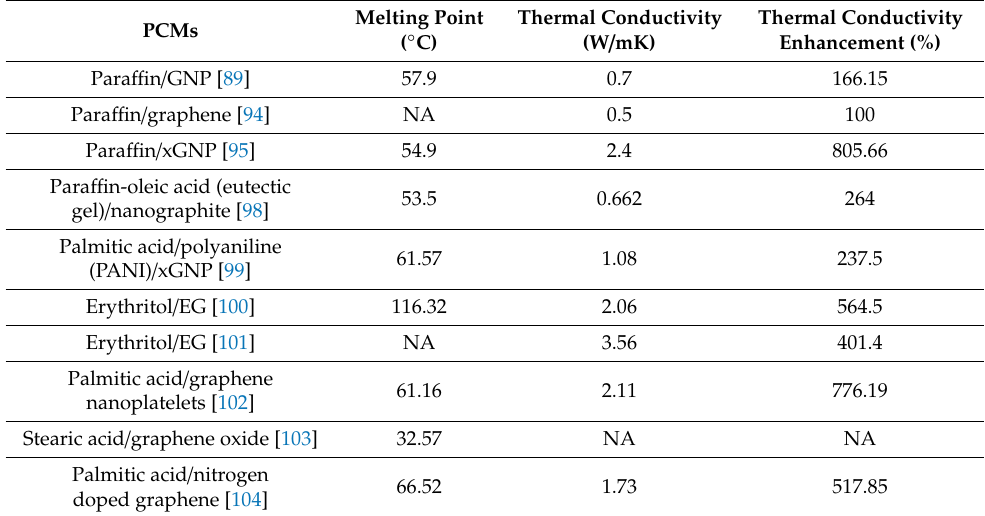
Figure 6. ( a ) DSC analysis of pure erythritol, the erythritol / RG composite, and erythritol / EG composites. ( b ) Changes in the latent heat of pure erythritol, the erythritol / RG composite, and erythritol / EG composites with thermal cycling. Table 4. Thermal properties of organic PCMs filled with graphite derivatives .